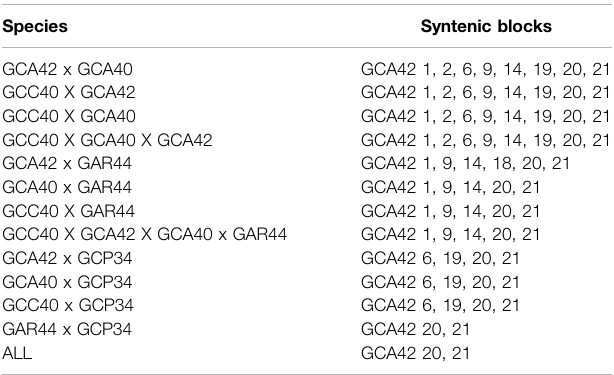
TABLE 2 | Syntenic blocks shared among analyzed species with WCP. GCA42 — Gymnotus carapo 2n = 42; GCA40 — G. carapo 2n = 40;